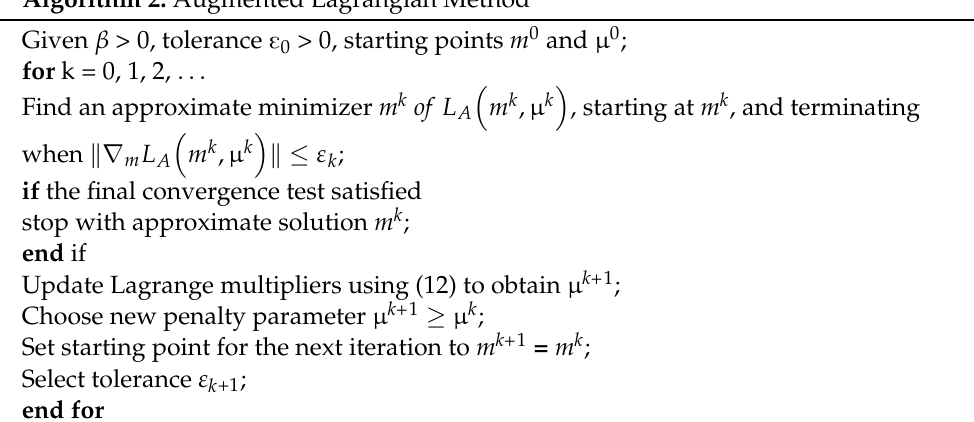
Algorithm 2: Augmented Lagrangian